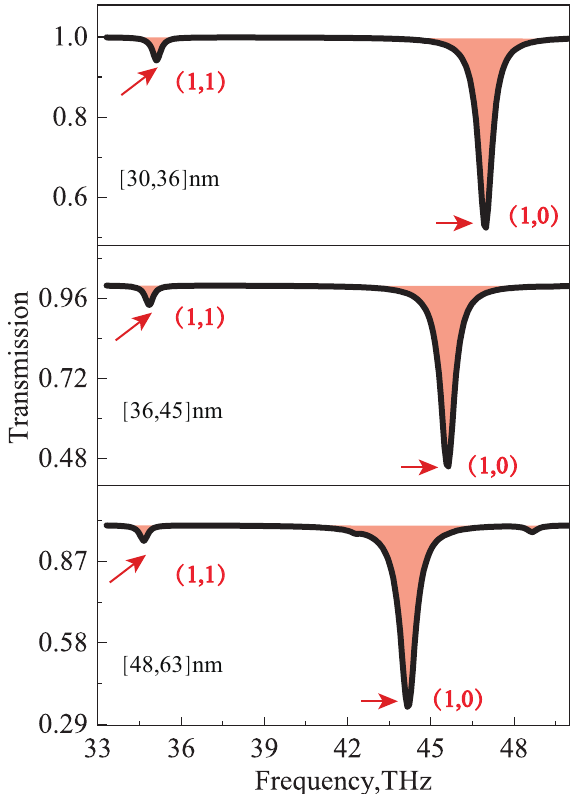
Figure 5. Transmission spectra of periodic indefinite nanoscale cavity array. 1D cavity array with a 50% cavity area filling ratio for different cavity sizes. Both higher − order (1, 1) and lower − order (1, 0) modes are indicated. All (1, 1) modes resonate at the same frequency of 37 THz, and lower order (1, 0) modes resonate at other higher higher frequencies.